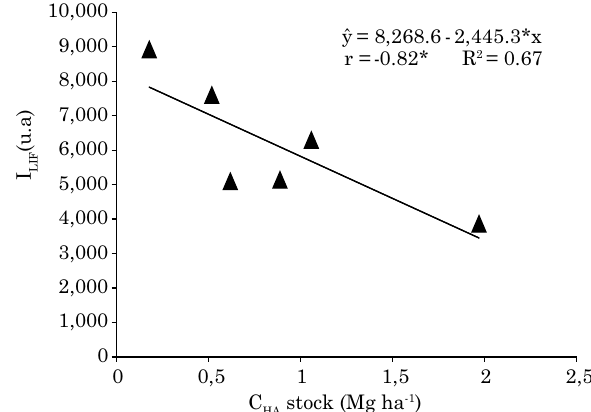
Figure 4. relationship between the humic acid stock (C ha ) and laser-induced fluorescence index (i liF ) of organic matter in the 0.00-0.03 m layer of a constructed soil under cover crops, a bare constructed soil and a natural soil in a coal mining area. * significant at 5